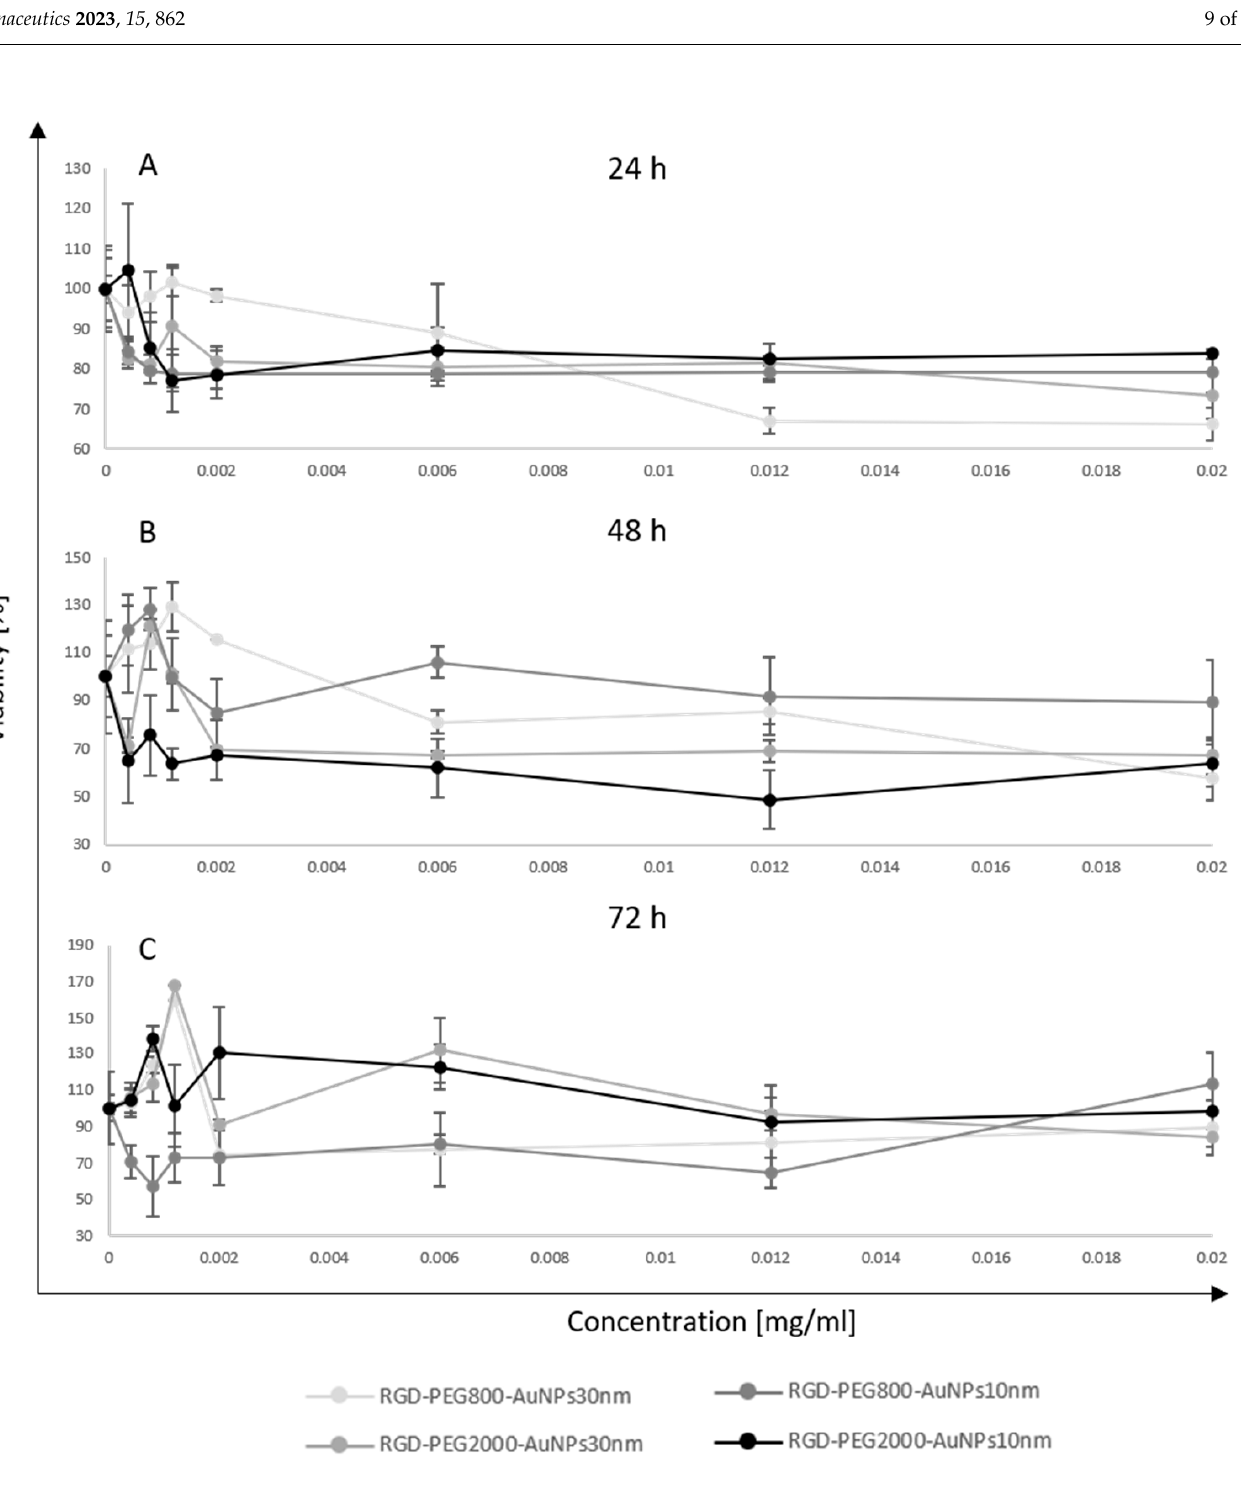
Figure 4. The viability level of the MCF-7 3D model after incubation with AuNPs. In this test, RGD-PEG 800 -AuNPs 10nm and RGD-PEG 2000 -AuNPs 10nm , RGD-PEG 800 -AuNPs 30nm and RGD- PEG 2000 -AuNPs 30nm were used in concentrations of 0.0004, 0.0008, 0.0012, 0.0020, 0.0060, 0.0120 and 0.0200 mg/mL. The time points of incubation time with AuNPs were 24 h ( A ), 48 h ( B ), and 72 h ( C